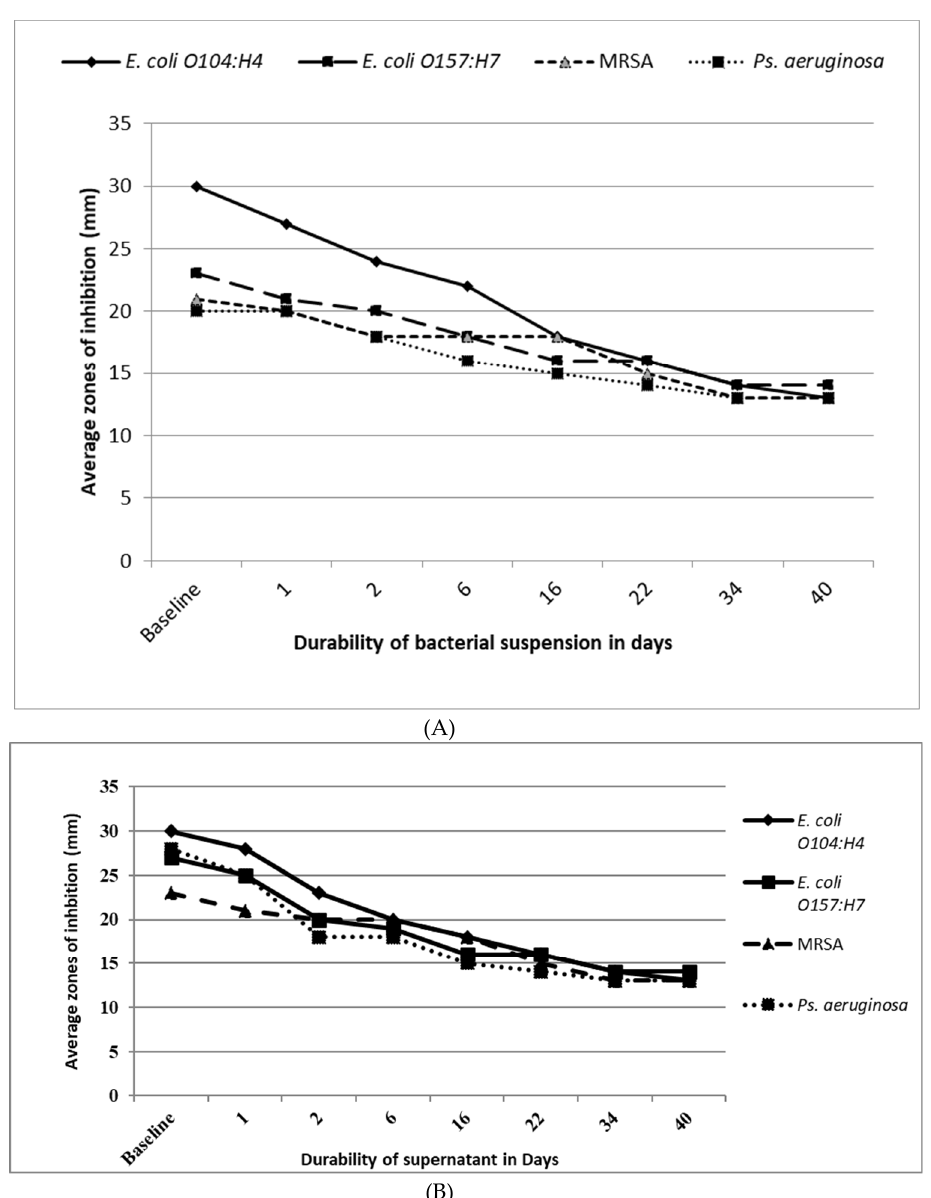
Figure 7. Baseline antimicrobial activity, efficacy and durability of silver treated E. coli O104:H4 (killed-bacteria suspension ( A ) and supernatant ( B )).